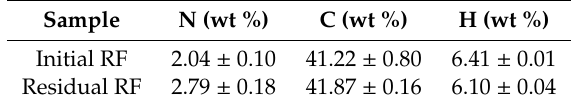
Table 3. CHNS elemental analyses of the initial ramon flour and residual ramon flour.